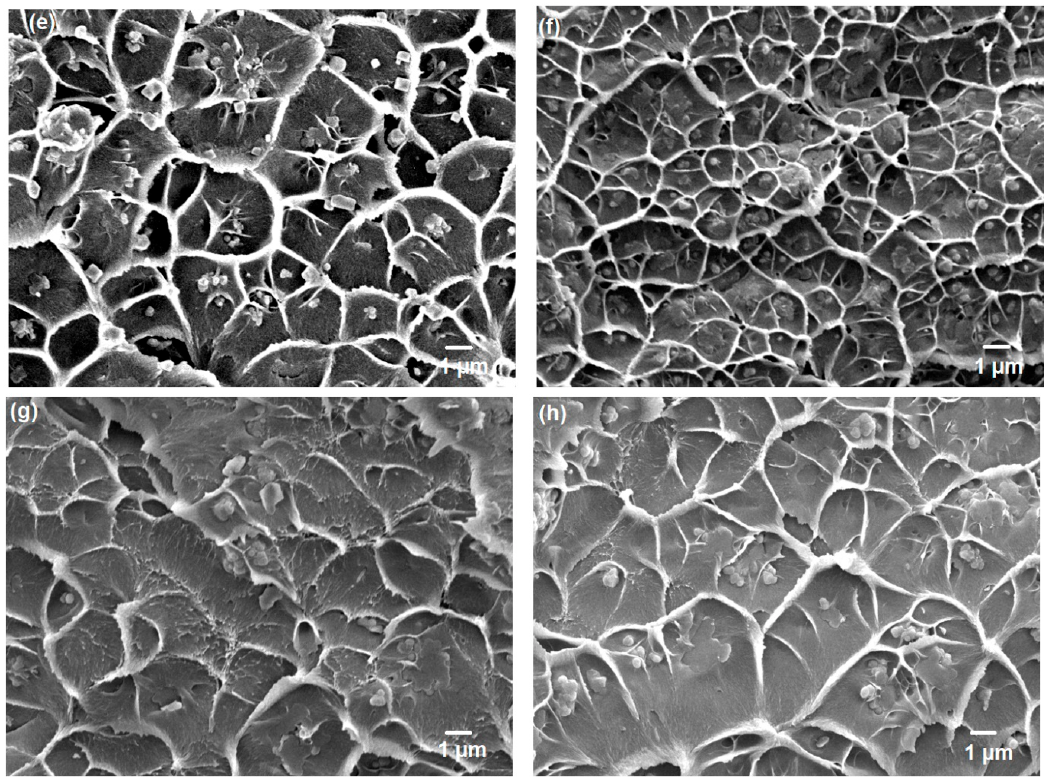
Figure 7. FESEM images of ( a ) 10 wt% UiO-66; ( b ) 20 wt% UiO-66; ( c ) 10 wt% UiO-66-NH 2 ; ( d ) 20 wt% UiO-66-NH 2 ; ( e ) 10 wt% UiO-66-Br; ( f ) 20 wt% UiO-66-Br; ( g ) 10 wt% UiO-66-(OH) 2 ; ( h ) 20 wt% UiO-66-(OH) 2 in ODPA-TMPDA membrane.